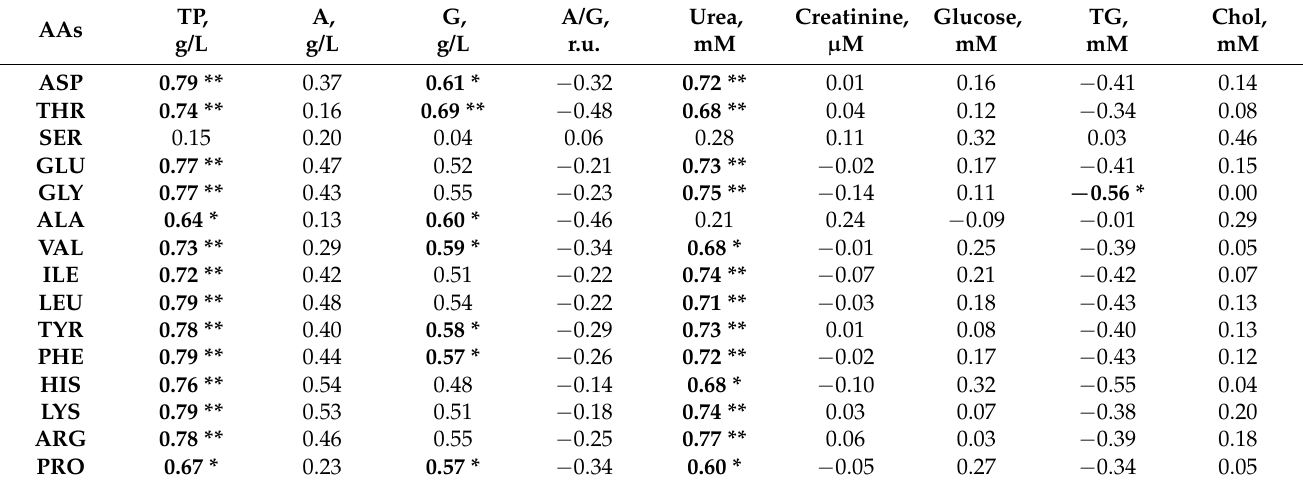
Table 8. The correlation coefficients between all obtained amino acids and the major biochemical parameters of the blood serum of Duroc pigs of the group 4 (90 days): TP, total protein; A, albumins; G, globulins; A/G, albumins to globulins ratio, urea, creatinine, glucose; TG, triglycerides; Chol, cholesterol (n =